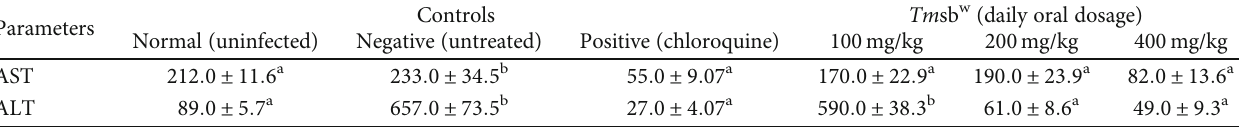
Table 4: Biochemical parameters of Pb B-infected mice treated with Tm sb w .